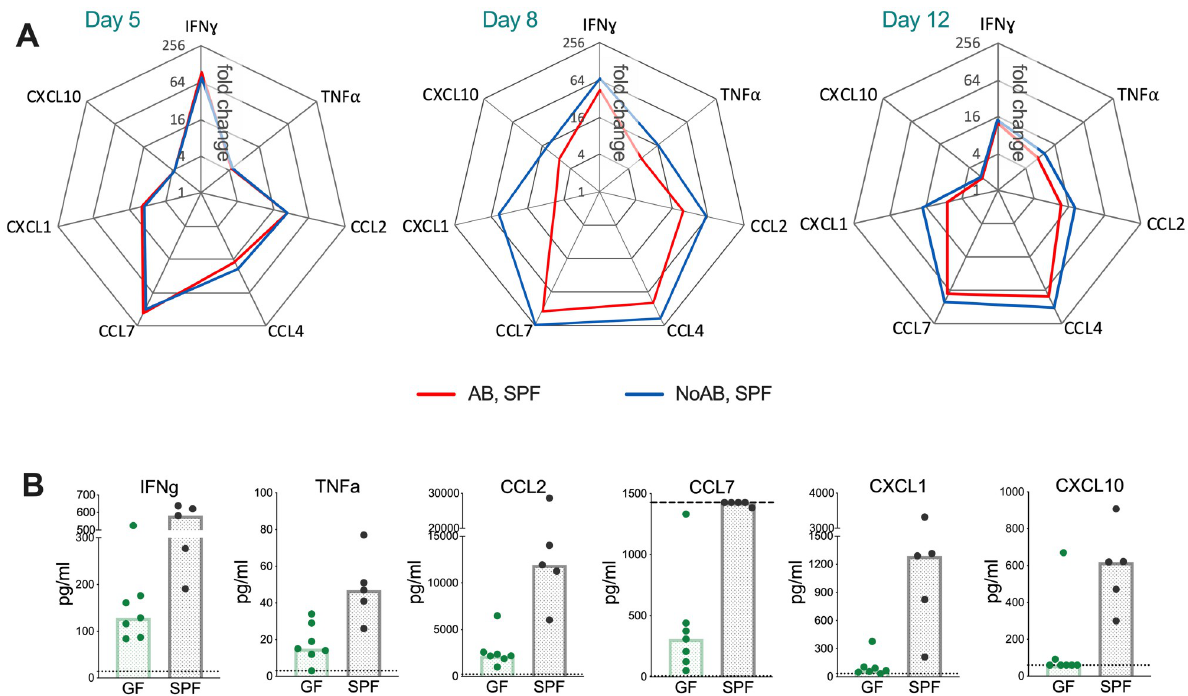
Fig 6. Skin microbiota promote the production of cytokines/chemokines in VACV-infected ear tissue. SPF or GF mice (n = 5–7 per group per time point) were injected i.d. with 10 4 PFU of VACV. SPF, AB-group received antibiotic (ceftriaxone) i.p. daily from 1 d p.i.; SPF, NoAB group received i.p. injections with PBS. (A) Tissue levels of cytokines and chemokines were measured by multiplex assay (Luminex). Data are shown as the fold change from the baseline (untreated intact ear samples). Means are shown. The experiment was performed twice and data from one representative experiment are shown. (B) Tissue levels of cytokines and chemokines in GF and SPF groups at d 10 p.i. measured by multiplex assay (Luminex). Graphs show results two independent experiments. Dotted lines indicate the lowest standards (or highest standard for CCL7). The experiment with GF animals was performed